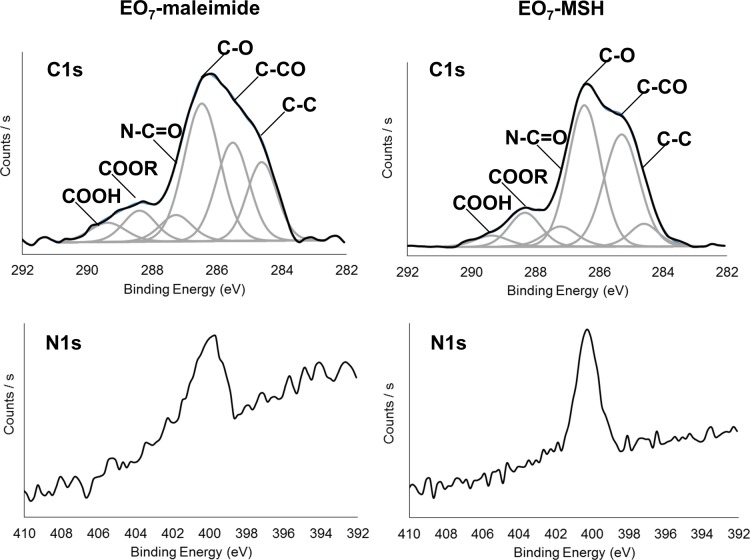
XPS analysis of maleimide linker and peptide modified surfaces.C1s and N1s high resolution spectra of the EO7-maleimide and EO7-MSH surfaces.